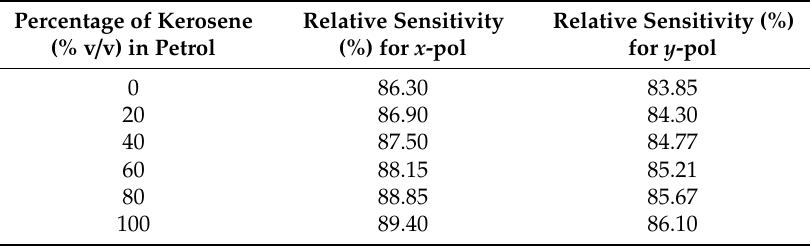
Figure 6. Relative sensitivity variation characteristics of the proposed fiber at different operating frequency when L = 280 µm. Table 2. Relative sensitivity of the proposed oil adulteration measurement sensor at L = 280 µ m and f = 2.8